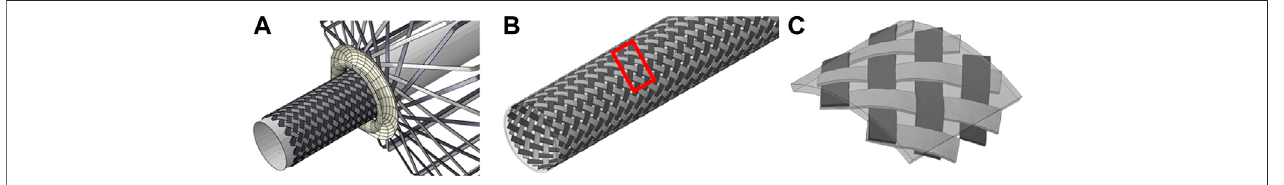
FIGURE3| Thebraidingsimulationofthepreformfornuclearcladding. (A) Thedynamicprocesssimulationusingcontactconstraints; (B) thebraidedclad; (C) the integration of preform mesh and the matrix mesh using the embedded region constraint.